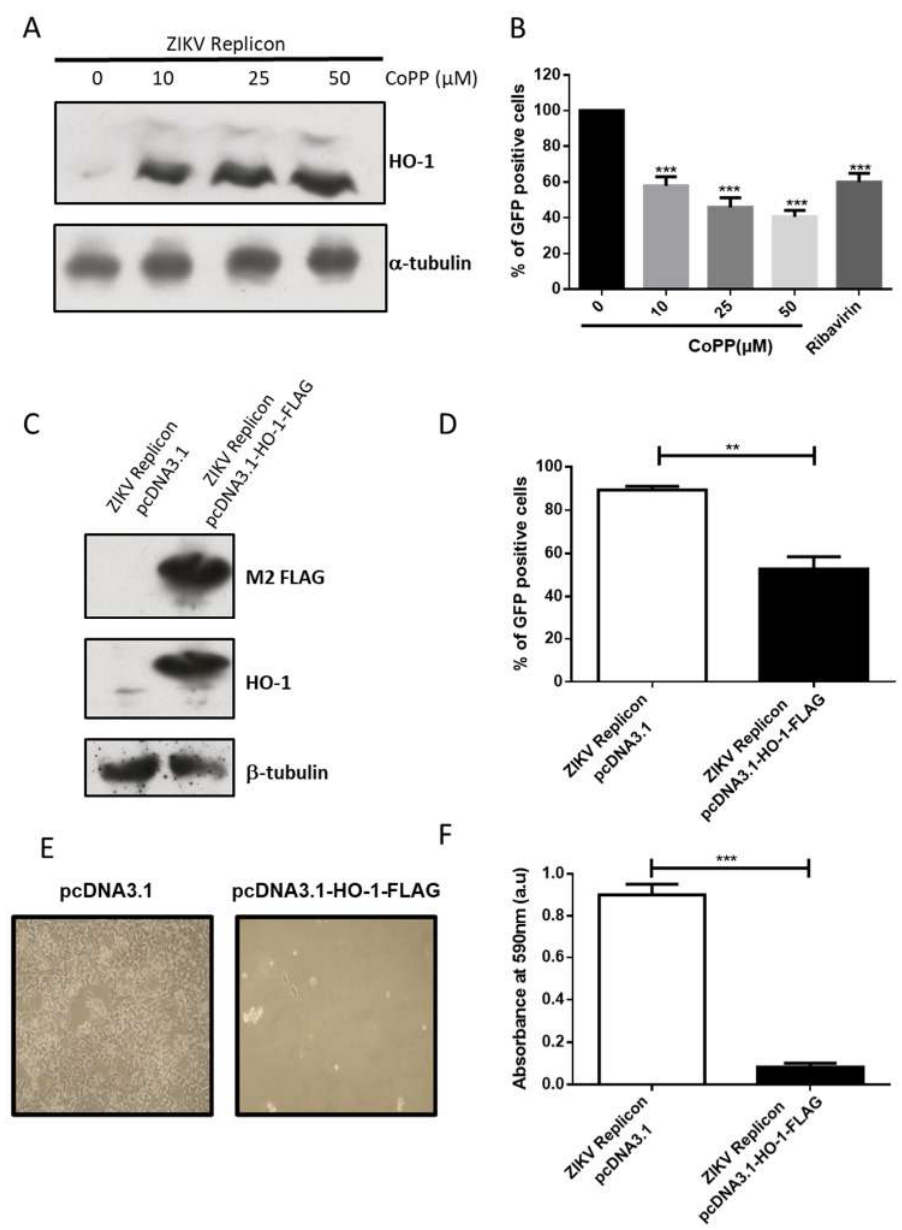
Figure 2. ZIKV replicon expression is inhibited by HO-1 induction or overexpression. ( A ) HO-1 protein expression was assessed by Western blot in HEK-293A cells expressing ZIKV replicon after treatment with several doses of CoPP for 20 h. Antibody against α -tubulin served as the protein loading control. ( B ) The percentage of GFP-expressing cells was analyzed by flow cytometry assay in ZIKV replicon cells after treatment with different concentrations of CoPP for 20 h. As positive control, cells were treated for 24 h with 40 µ g · mL − 1 (164 µ M) of ribavirin. *** p < 0.001. ( C ) Overexpression of HO-1 in ZIKV replicon cells transfected with pcDNA3.1-HO-1-FLAG-Neo was assessed by Western blot using the anti-FLAG M2 and antibody against HO-1. Antibody against β -tubulin served as protein loading control. ( D ) The percentage of GFP-expressing cells was analyzed by flow cytometry assay in ZIKV replicon cells after transfection with pcDNA3.1-HO-1-FLAG encoding the human HO-1 protein or with pcDNA3.1. ** p < 0.01. In ( E ) and ( F ), cell viability was observed by optical microscopy or crystal violet staining respectively in ZIKV replicon cells transfected with pcDNA3.1 or pcDNA3.1-HO-1-FLAG after 7 days of treatment with G418 and puromycin to respectively allow the expression of HO-1 and the expression of ZIKV replicon. *** p < 0.001.